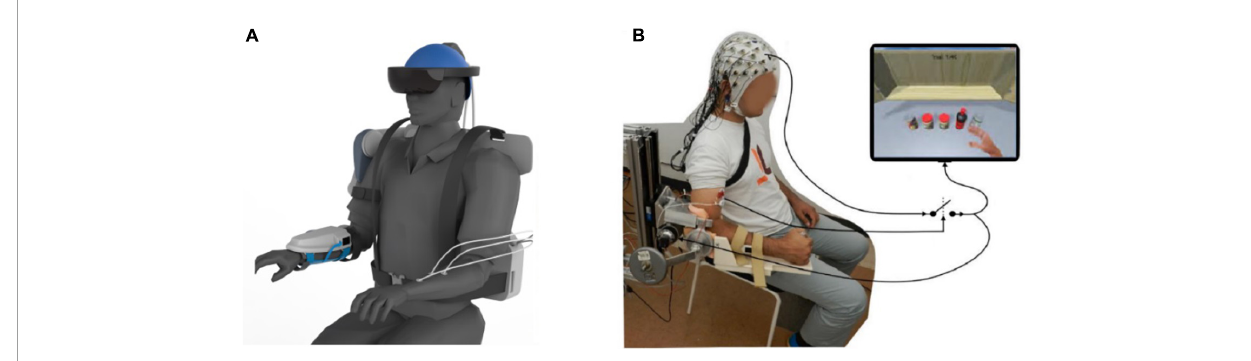
FIGURE1 Motor imagery brain-computer interface (MI-BCI) upper limb rehabilitation system. (A) Ideal MI-BCI system. (B) Actual usage